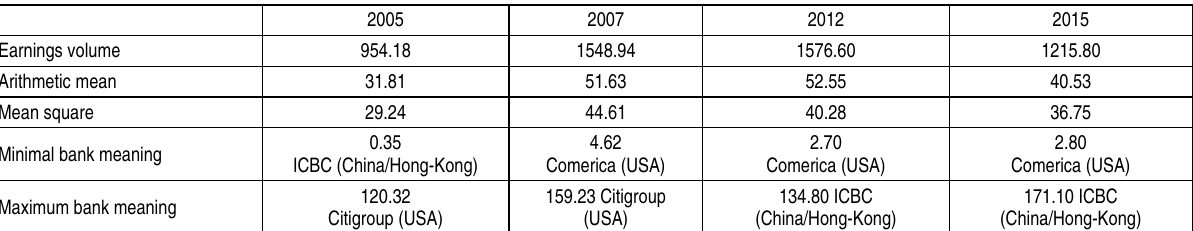
Table 2. The dynamics of earnings volume of thirty world major banks, bln US dollars